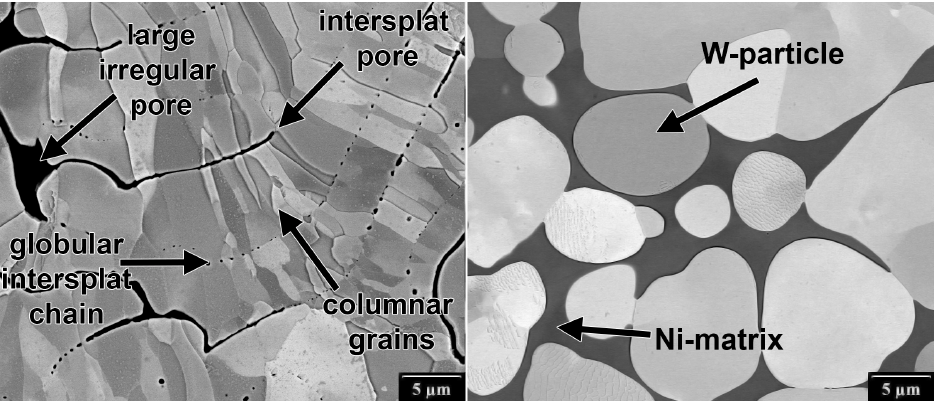
Figure 4. Typical micromorphological features seen in Mo and W deposits illustrated using W (coarse) deposit ( left ), and typical features of WHA illustrated using W-20Ni deposit ( right